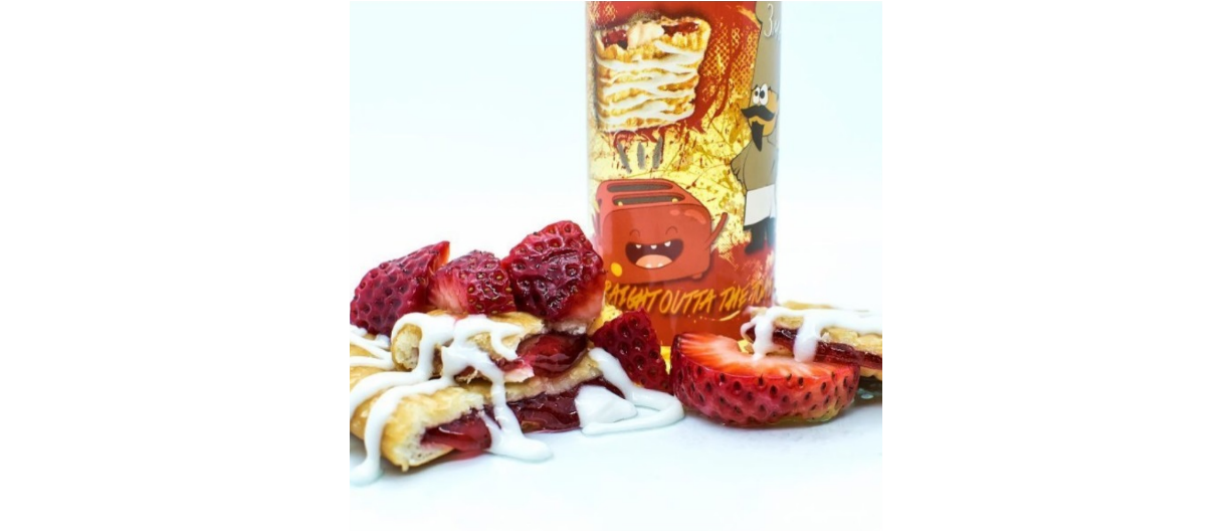
Figure 3. Example of a flavor within the "promotional practices and strategies"